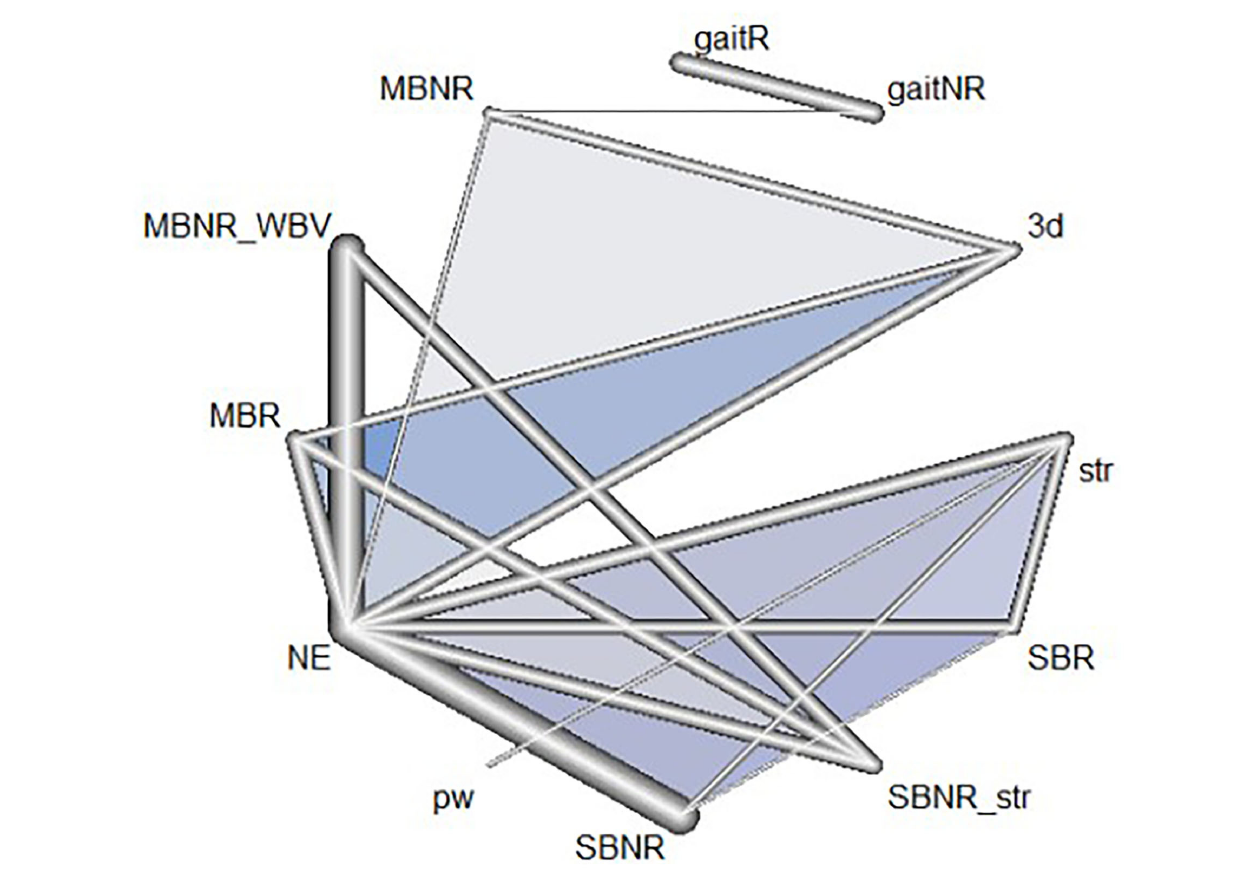
FIGURE 6 | Network geometry of the included exercise programs in healthy older adults: Each line indicates a direct comparison of two different exercise programs. The thickness of the edge is proportional to the number of direct comparisons in the network. Different exercise types combined in one program are connected via underscores. The blue triangles refer to multi-arm trials comprised of three exercise programs in the nodes. SBR, Single balance exercise including reactive balance component; SBNR, Single balance exercise not including reactive balance component; MBR, Multiple balance exercises including reactive balance component; MBNR, Multiple balance exercises not including reactive balance component; gaitR, Gait training including reactive balance component; gaitNR, Gait training not including reactive balance component; WBV, Whole body vibration; str, Strength; pw, Power; 3d, 3D exercise; NE, No